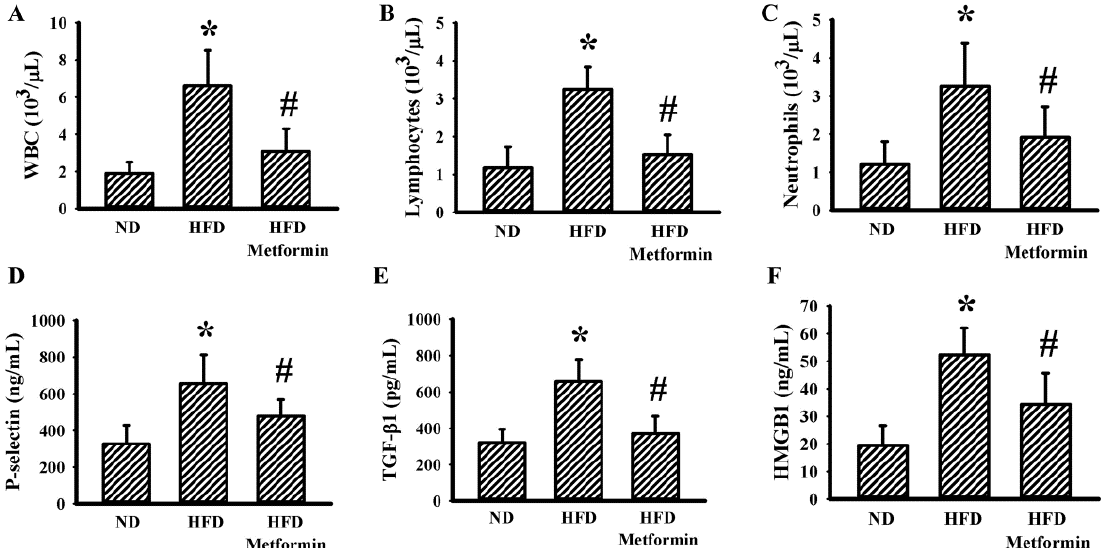
Figure 3. Metformin mitigated inflammatory alterations in obese mice. ND-fed lean and HFD-fed obese mice were subcutaneously inoculated with LLC cells over a course of three weeks. Three days after cell implantation, ND-fed lean mice were treated daily with saline vehicle through intraperitoneal injection (ND). HFD-fed obese mice were separated into two groups receiving daily intraperitoneal injections of a saline vehicle (HFD) or metformin (50 mg/kg, HFD/Metformin) for the final 18 days. The levels of WBCs ( A ), lymphocytes ( B ), neutrophils ( C ), soluble P-selectin ( D ), TGF- β 1 ( E ) and HMGB1 ( F ) in blood samples were all determined. * p < 0.05 vs. ND and # p < 0.05 vs. HFD, n = 6.